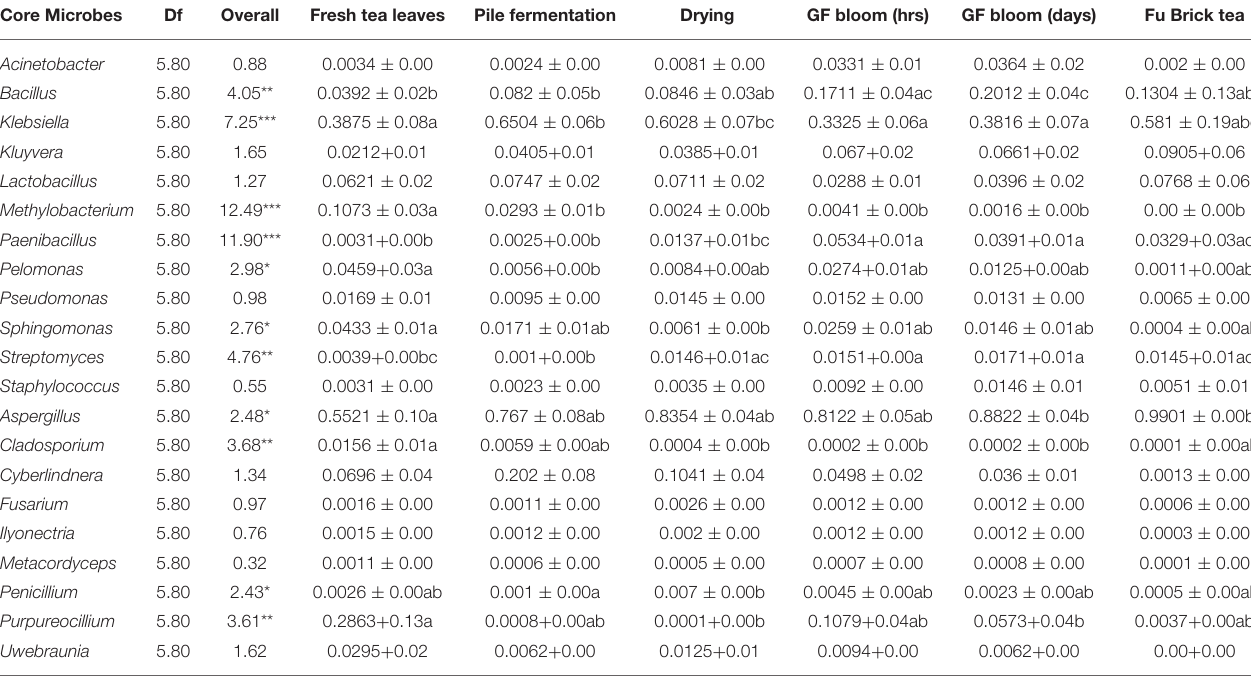
“Core microbes” are listed at the genus level and found in ≥ 80% of all samples or had an average relative abundance of > 1%. “Df” is the degree of freedom. “Overall” is the effect of fermentation stages following a linear mixed model, presented as F-values. * , ** , and *** indicate P < 0.05, 0.01, and 0.001, respectively. “GF bloom (h)” is the early stage golden flower bloom and “GF bloom (d)” is the full golden flower bloom. In each manufacturing stage, values are mean + se of the relative abundances of microbial genera. Letters following mean ± se indicate significant differences in the mean (P <